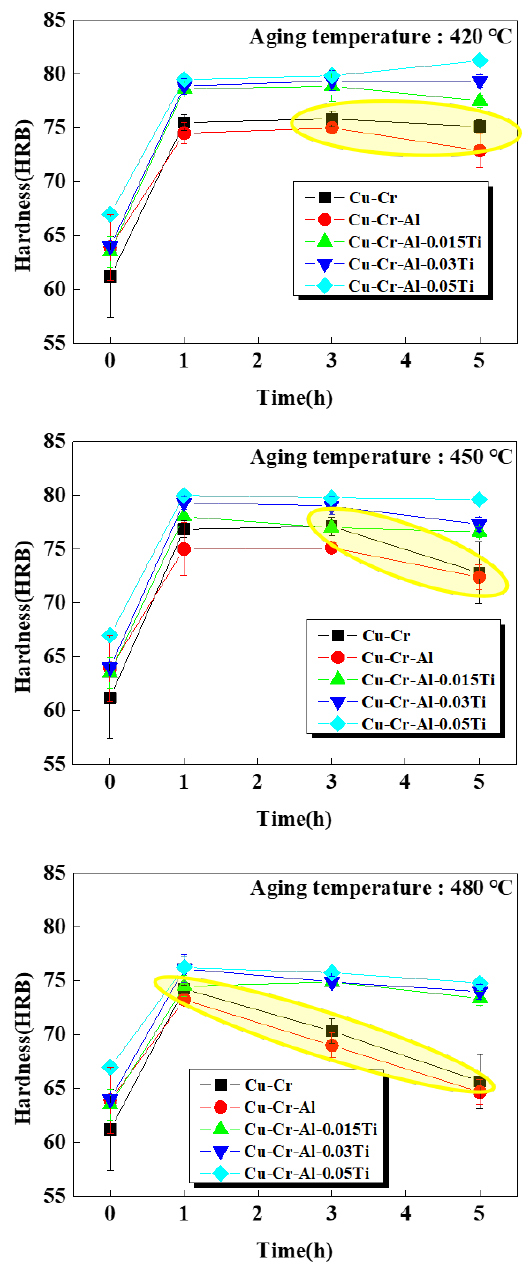
Figure 8. Variation of hardness of Cu-Cr alloys after aging treatment.